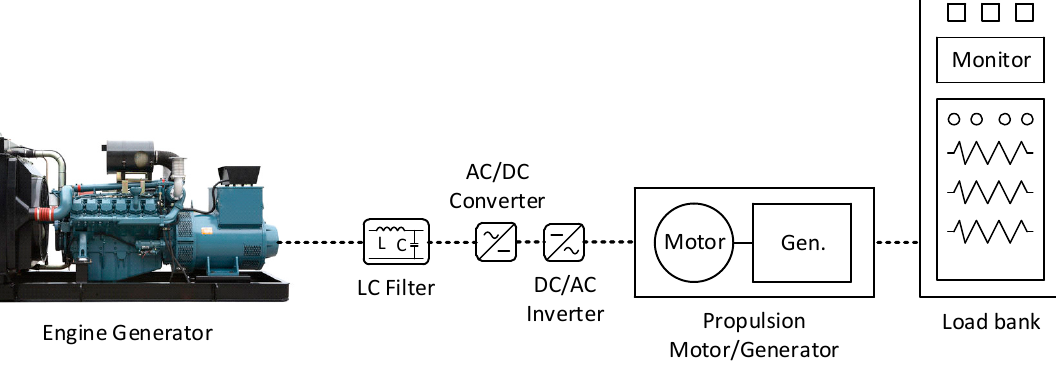
Figure 4. Schematic minimalistic diagram of the DC distribution system designed for the MASTC laboratory. Table 1. Specifications of the AFE rectifier (AC/DC